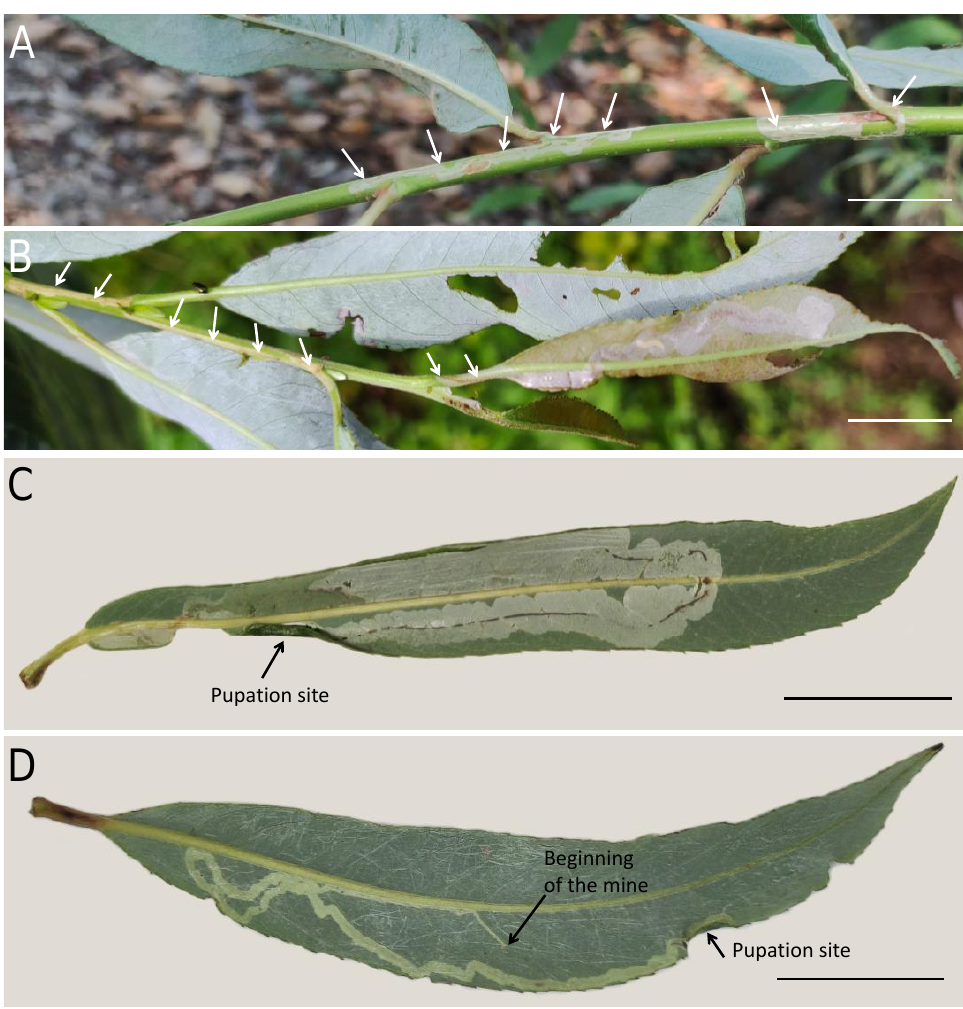
Figure 10. The mines of Phyllocnistis saligna ( A – C ) and P. valentinensis ( D ) on Salix alba in the Volčji Potok Arboretum, Slovenia, 9 August 2022. ( A , B ) a tunnel (shown by arrows) in the twig and the leaf mine with feeding larva ( B ); ( C ) a relatively broad leaf mine of P. salinga occupying most of the leaf lamina and the pupation site at the leaf margin; ( D ) a narrow tunnel of P. valentinensis wholly located on the leaf lamina. Scale: ( A , B ) 10 mm; ( C , D ) 20 mm. Photo: N.I. Kirichenko, S.